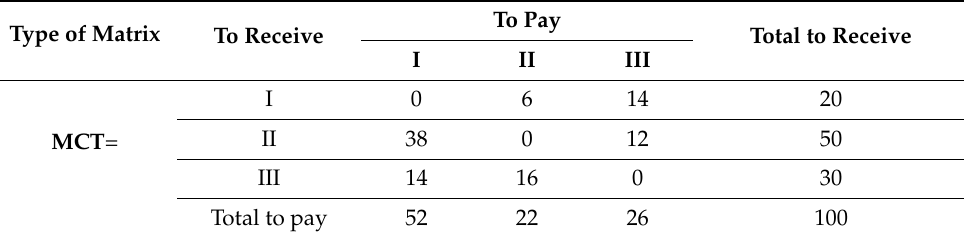
Table 5. The Matrix of Credit Turnovers MCT in a matrix form.